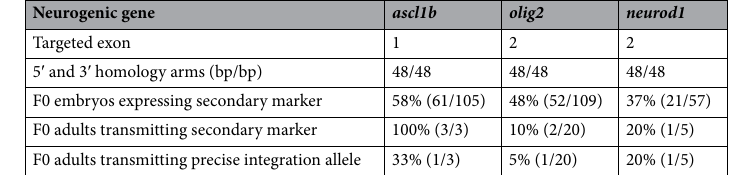
Table 1. Efficient recovery of endogenous neurogenic Cre driver lines by 2A-Cre-γcry:EGFP targeted integration.